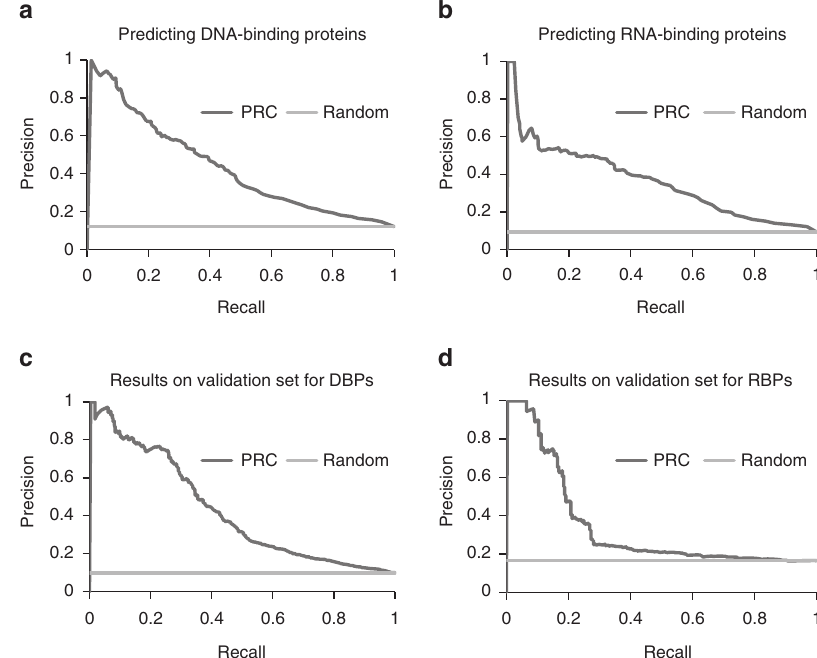
Figure 2 | Precision-recall curves (PRC) for predicting NA binding proteins. We assessed the PRC of each prediction method on two datasets: cross-validation on the set that was used to train the method, and an independent validation set ( a ) predicting whether a protein binds DNA, using cross-validation with the original set. ( b ) predicting whether a protein binds RNA, using cross-validation with the original set. ( c ) predicting whether a protein binds DNA, using an independent validation set. ( d ) predicting whether a protein binds RNA, using an independent validation